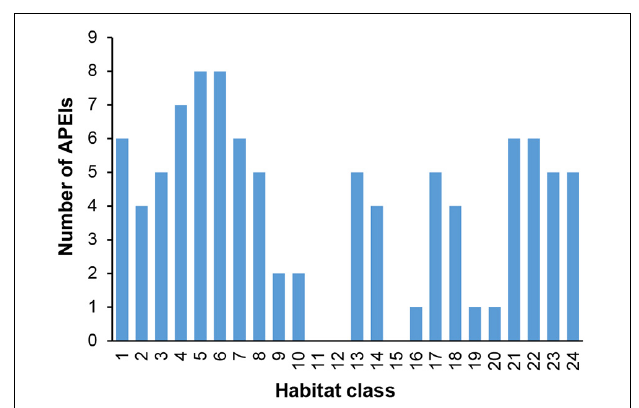
FIGURE 9 | Number of APEIs within which each habitat class is